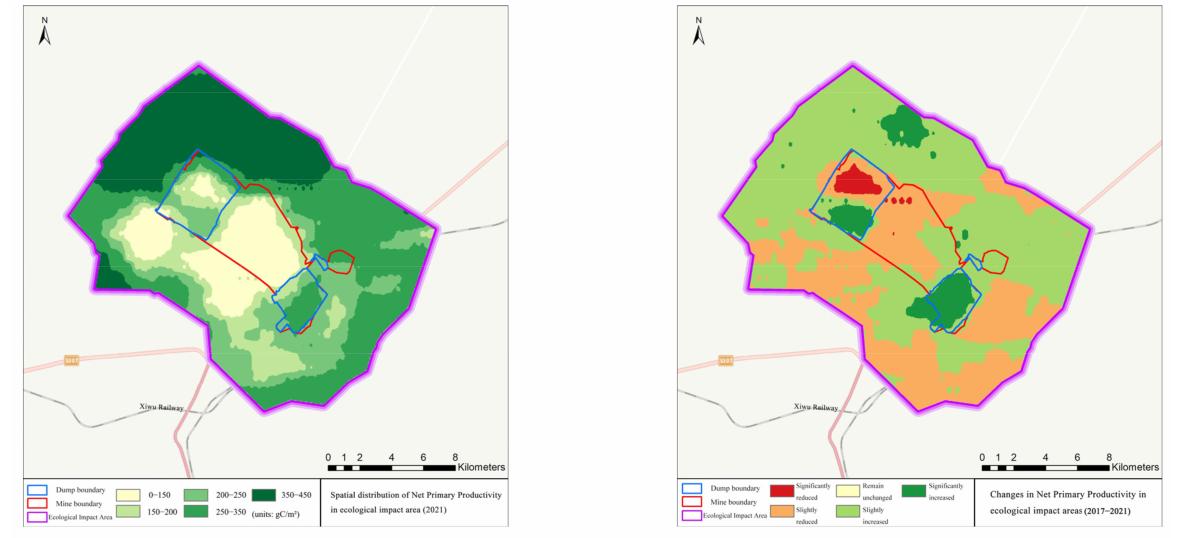
Figure 6. Spatial variation of vegetation coverage and changes of net primary productivity in the ecological impact area.